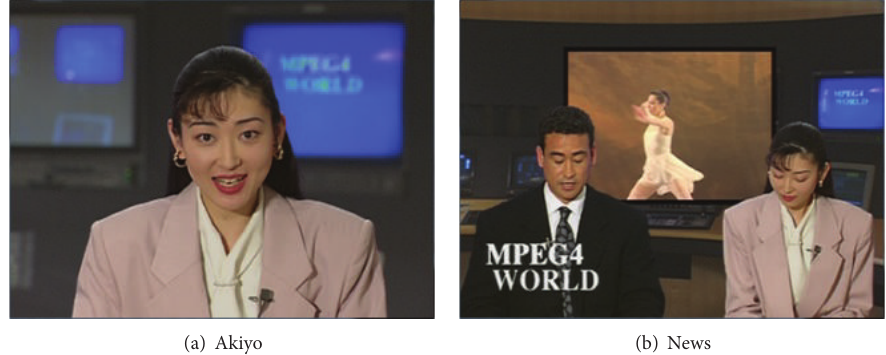
Figure 7: Sample images of uncompressed MPEG-4 standard images.